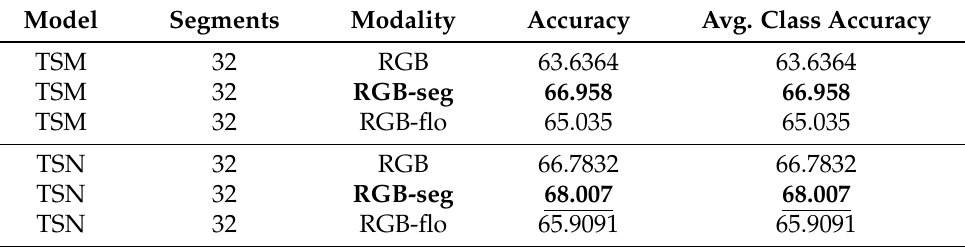
Table 4. Results of TSM and TSN with different modalities using the 11 action classes of the IPN Hand